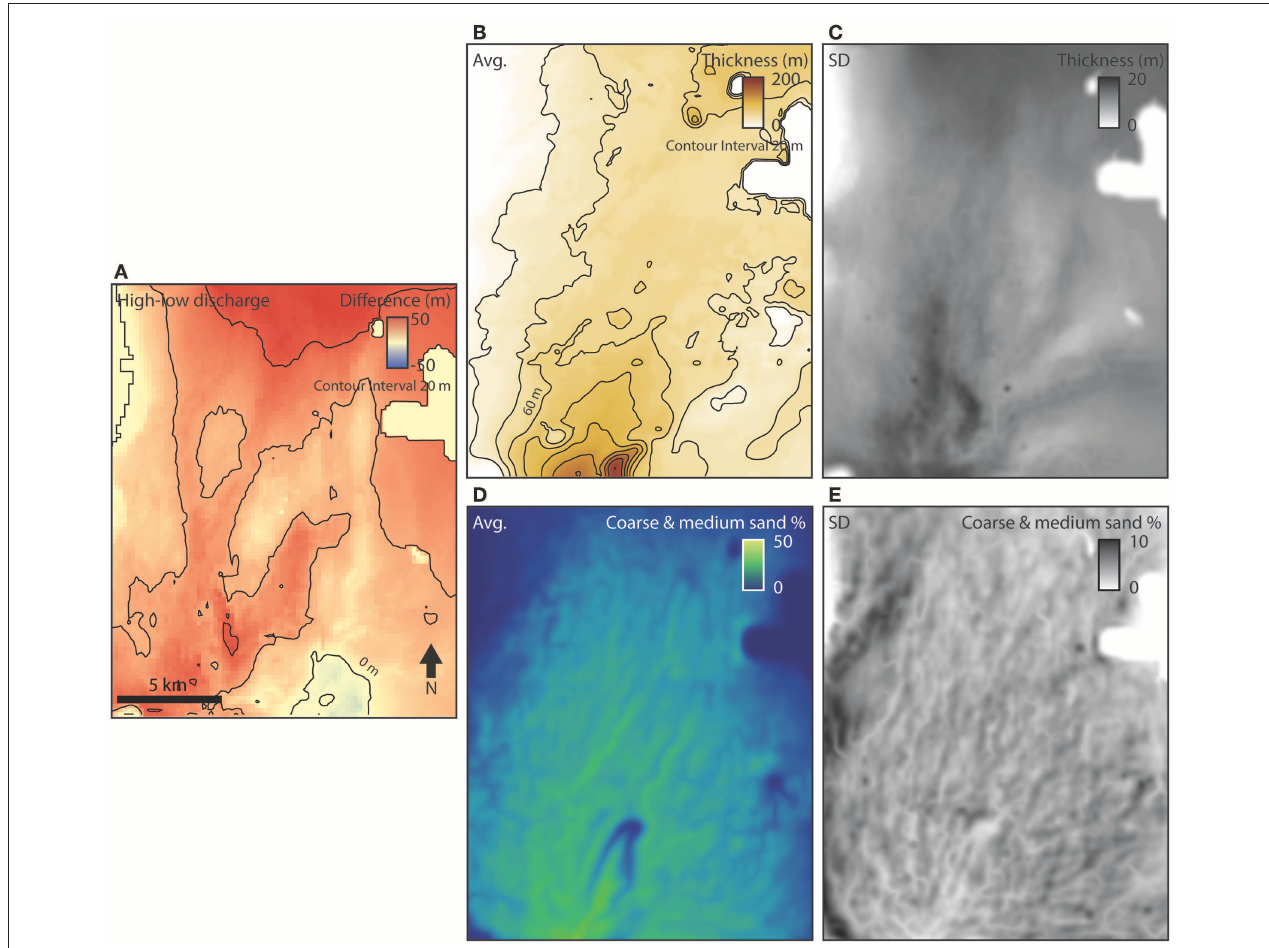
FIGURE 10 | (A) Difference in thickness between the high and low discharge models. (B–E) Simulation results. (B) Average of thicknesses. (C) Standard deviation of thicknesses. (D) Average of coarse and medium sand percentages. (E) Standard deviation of coarse and medium sand